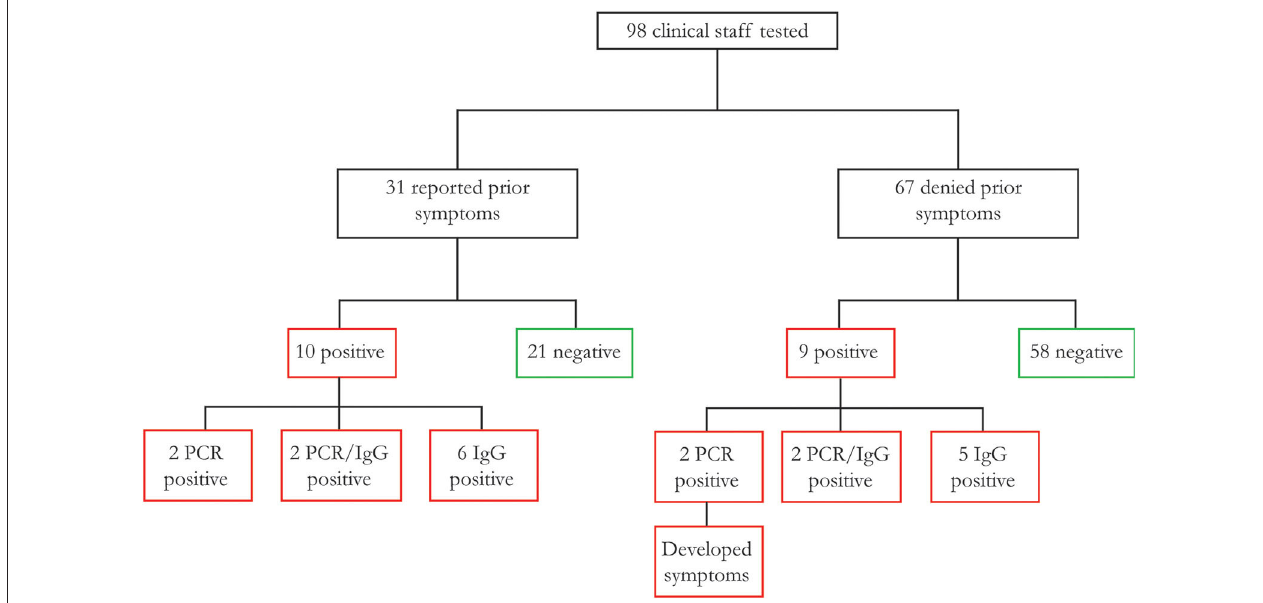
FIGURE 1 | Association between prior complaint of COVID-19 symptoms and SARS-CoV-2 infection of 98 healthcare worker participants, 31 reported typical COVID-19 symptoms prior to study participation, of whom 32.3% were found to have a history of SARS-CoV-2 infection (as defined by RT-qPCR or serology). There were an additional nine participants with no symptoms prior to study participation, of whom two subsequently developed symptoms (PCR positive), and with others asymptomatic as of this